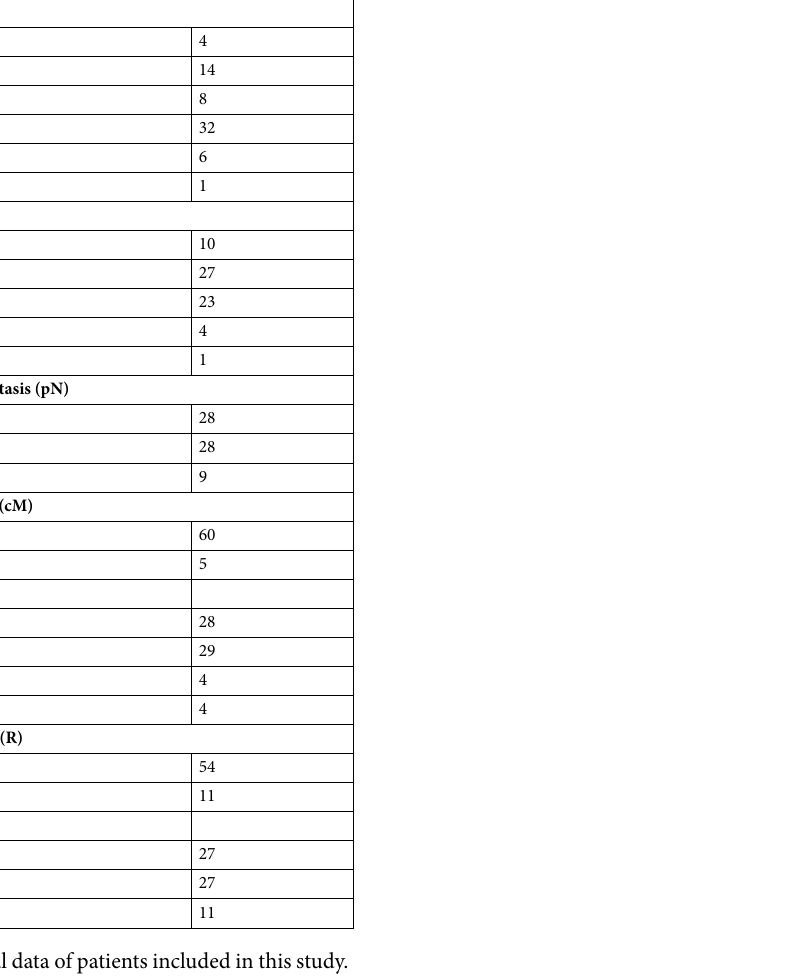
Table 1. None of the patients had received neoadjuvant chemotherapy. The progression-free survival (PFS) served as a measure of the treatment outcome. The PFS was defined as the time elapsed between surgical resection and disease recurrence or death. The OS was defined as the time elapsed between surgical resection and death of any cause. All procedures performed in this study were in accordance with the ethical standards of the Ethical Commission of the Medical Faculty and Teaching Hospital in Pilsen, Czech Republic (approval reference no. 301/2019) and with the 1964 Helsinki declaration and its later amendments or comparable ethical standards. Experimental protocol of this study was also approved by the Ethical Commission of the Medical Faculty and